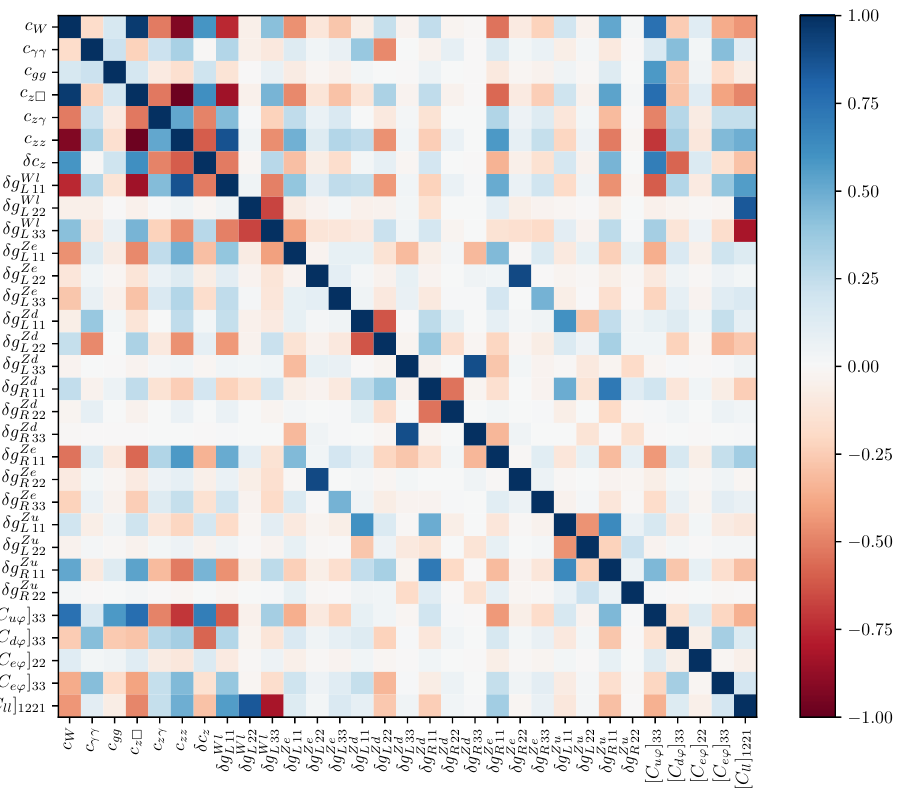
Figure 1 . The correlation matrix for the constraints on Wilson coe(cid:14)cients in the 31-parameter (cid:12)t in table